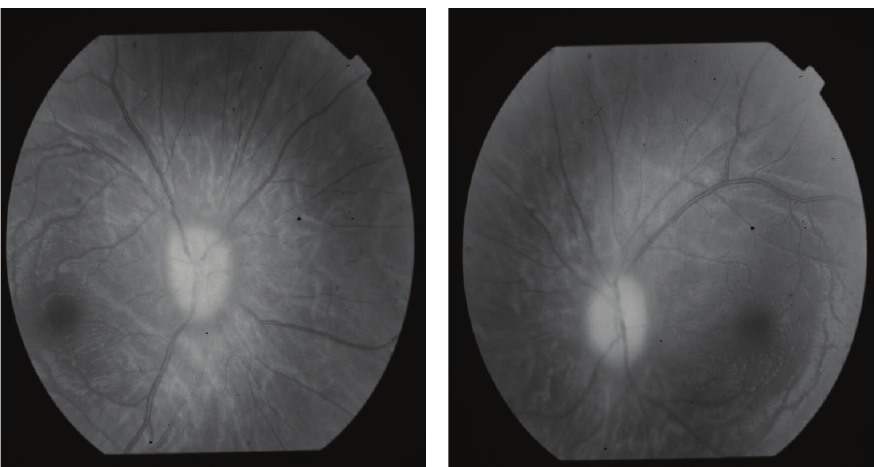
Figure 1: Funduscopic examination. Papilledema is seen on funduscopic examination.